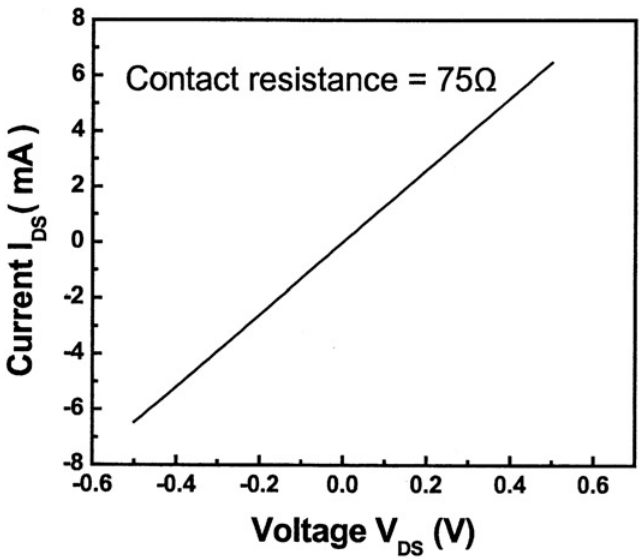
FIGURE 10 The I ds – V ds characteristic of InAlAs = InGaAs HEMT with gate